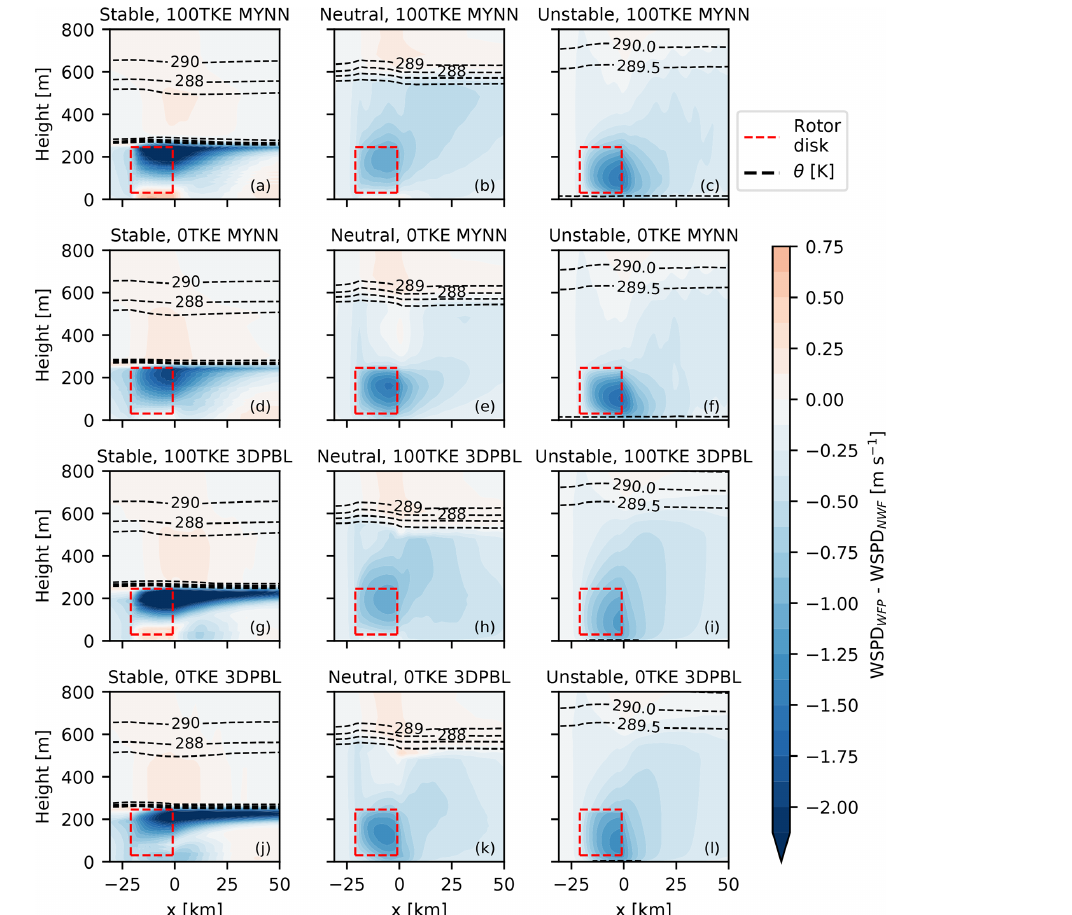
Figure 4. Side view of horizontally averaged wind speed deficits in varying stability conditions (left–right) and PBL configurations (up– down). Horizontal averaging was taken between the northernmost and southernmost turbines. The height of the ABL is conveyed with θ